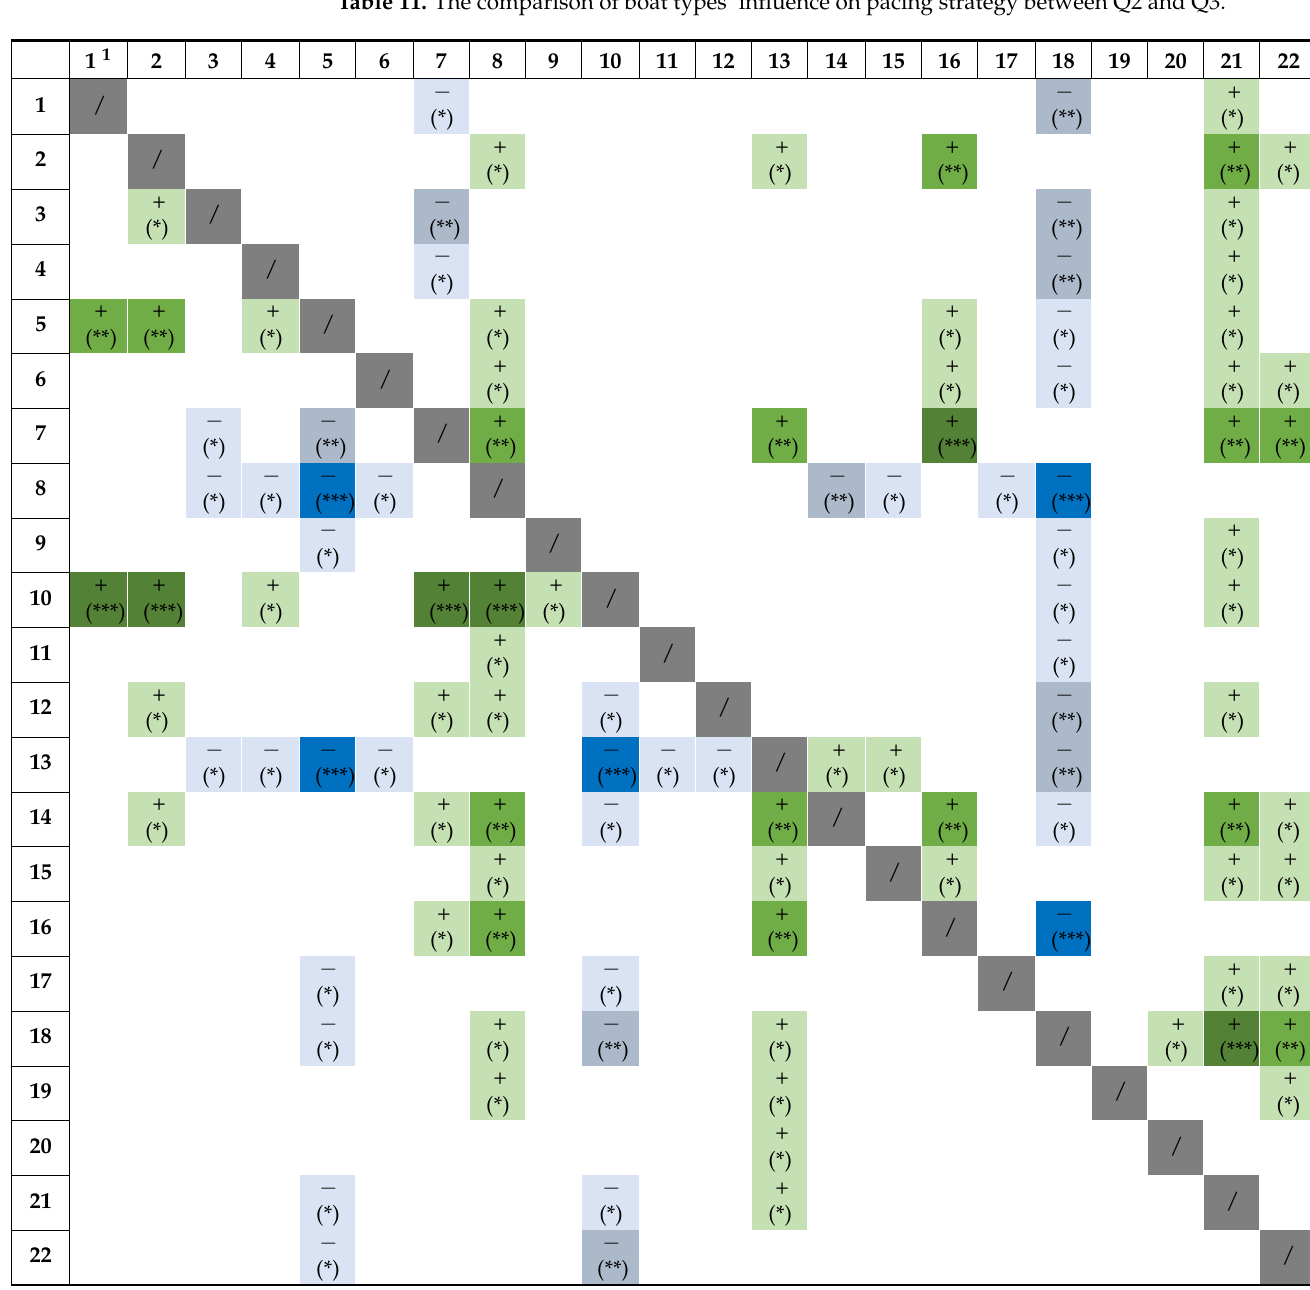
Table 11. The comparison of boat types’ influence on pacing strategy between Q2 and